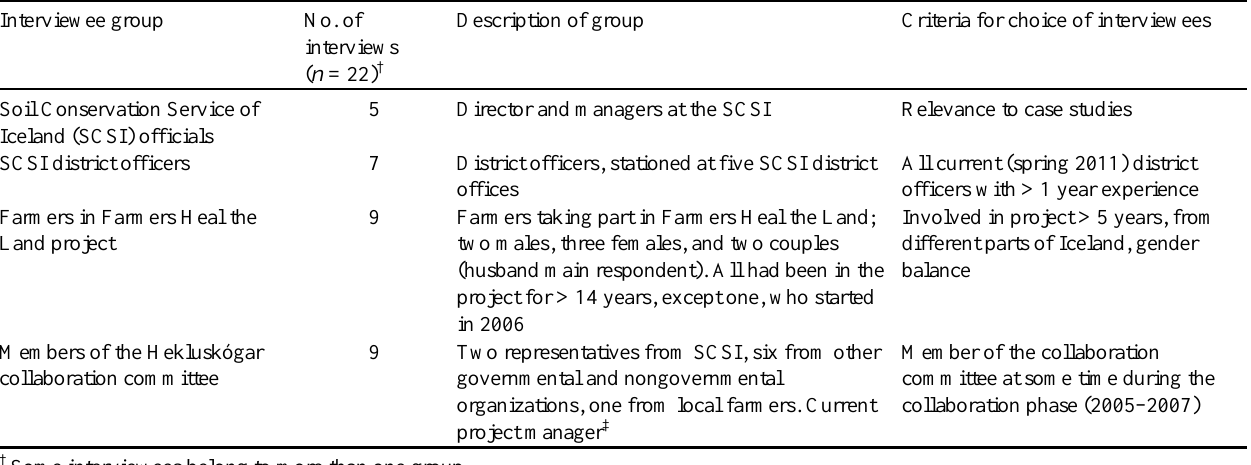
Table 3 . Description of interviewee groups and number of